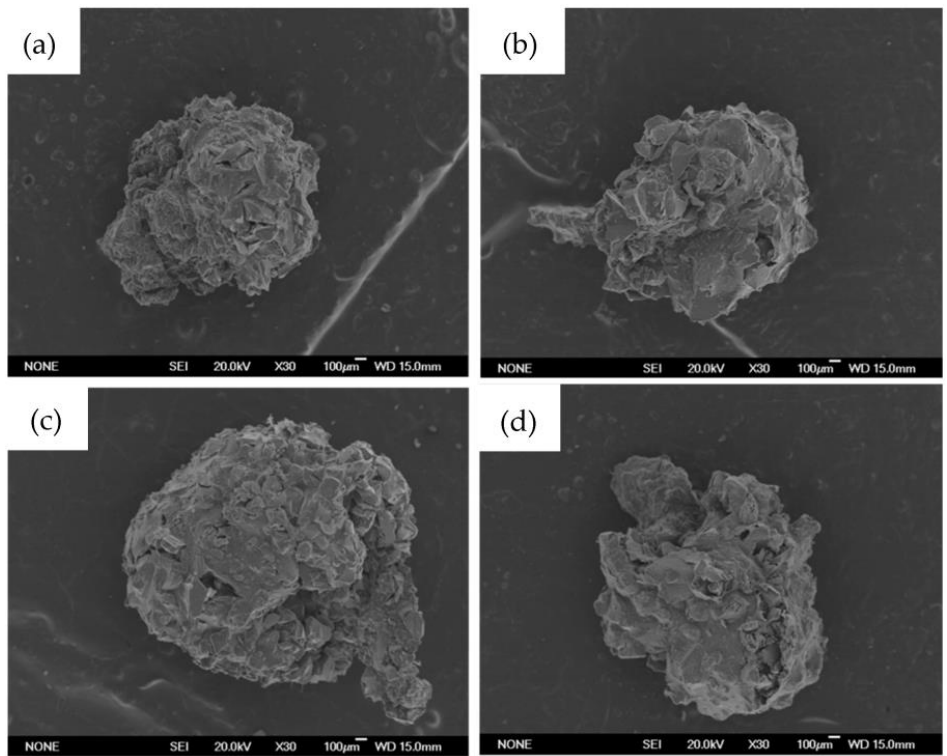
Figure 1. Bead images obtained with scanning electron microscope (SEM). In order: ( a ) B-MG; ( b ) B-MG_5.0Ce; ( c ) B-MG_curc5; and ( d ) B-MG_5.0Ce_curc5.